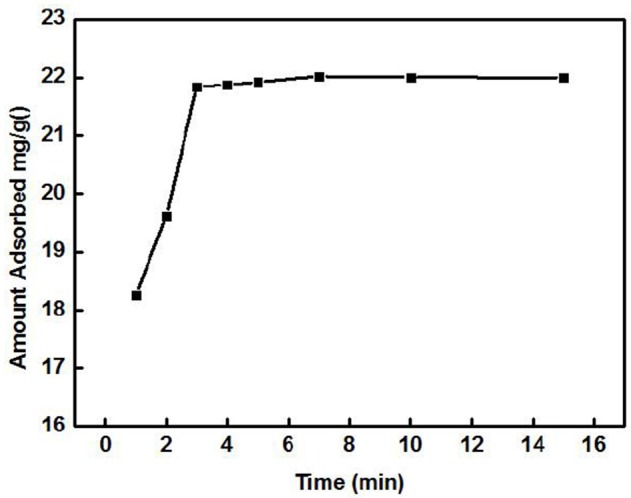
Effect of solution time on adsorption of Cd2+ by ZSR-P.